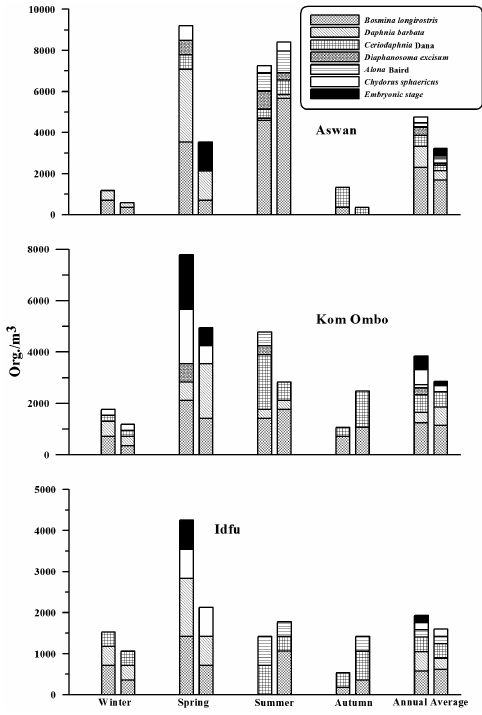
Figure 13. Distribution and seasonal variations of Cladocera in the River Nile. Left bar (upstream) and right bar (Downstream).